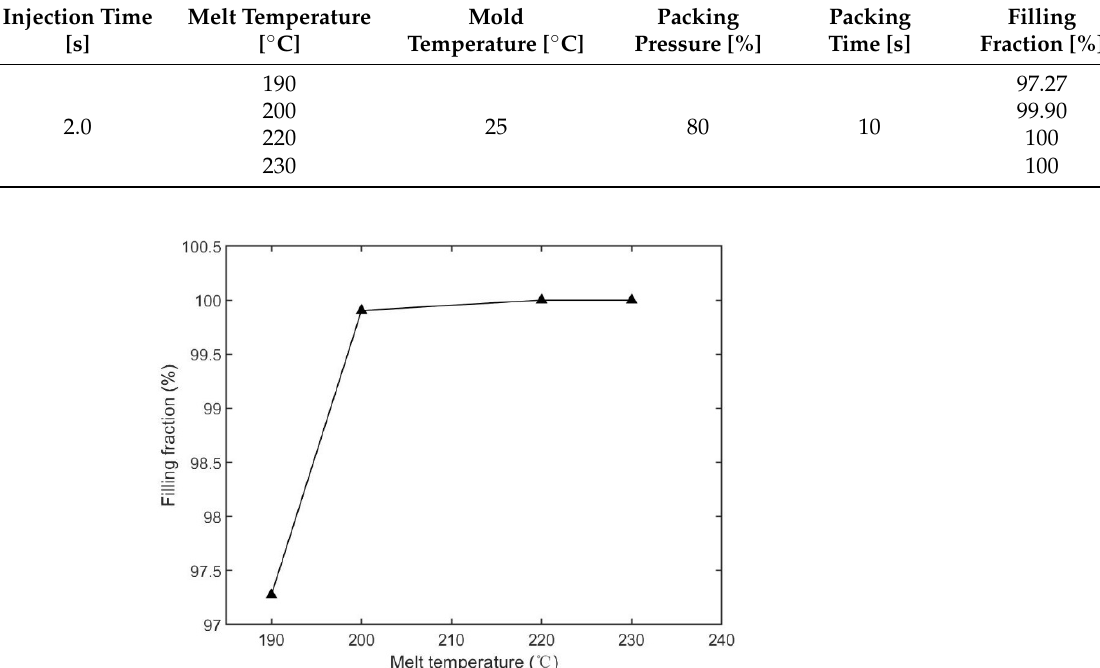
Table 4. Processing parameters of the melt temperature study. Only melt temperature was changed.